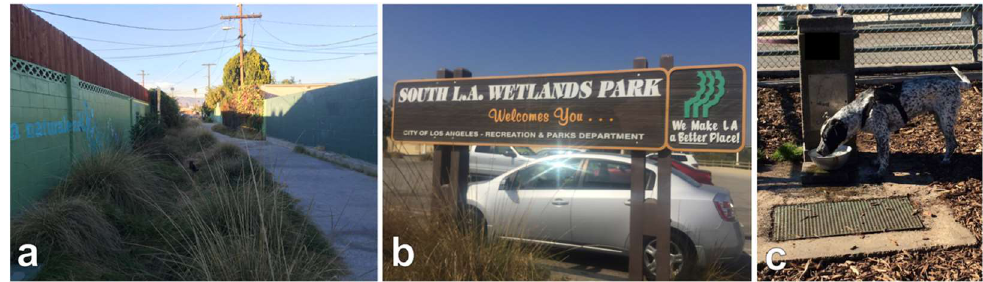
Figure 7. Visual indicators of recreation at Los Angeles natural stormwater treatment systems: ( a ) walking trail on Elmer Avenue Paseo, and ( b , c ) signage and drinking fountains at South Los Angeles Wetlands Park.